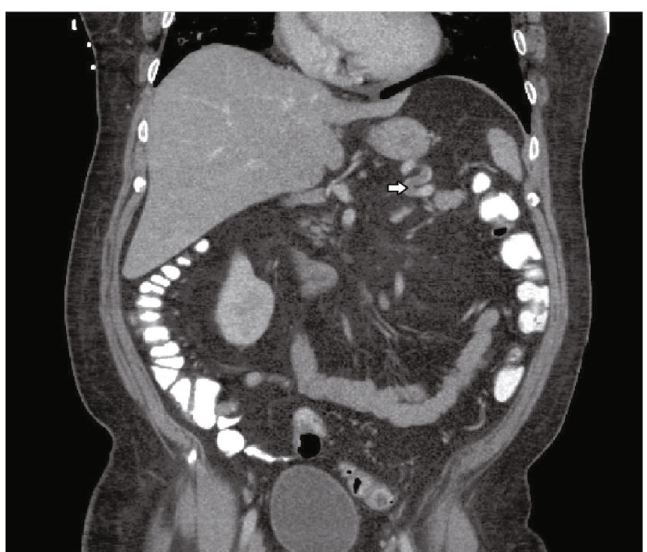
Figure 3: A fi lling defect within the mid to distal splenic artery consistent with splenic artery thrombosis, coronal